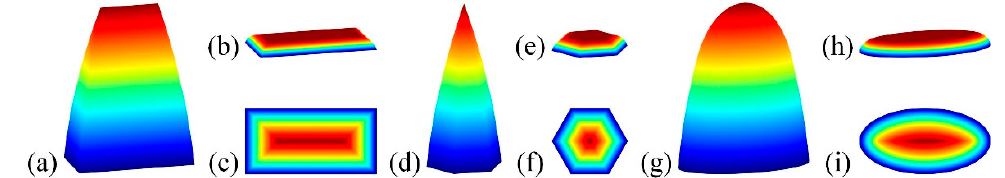
Figure 9. Effects of different parameters on steady-state ablation morphology of fibers: ( a ) η = 10, χ = 2.5 × 10 ‒ 5 m; ( b ) η = 10, χ = 5 × 10 ‒ 7 m; ( c ) η = 10, χ = 5 × 10 ‒ 8 m; ( d ) η = 200, χ = 5 × 10 ‒ 7 m; ( e ) η = 20, χ = 5 × 10 ‒ 7 m; ( f ) η = 2, χ = 5 × 10 ‒ 7 m; ( g ) effect of characteristic length on fiber morphology.